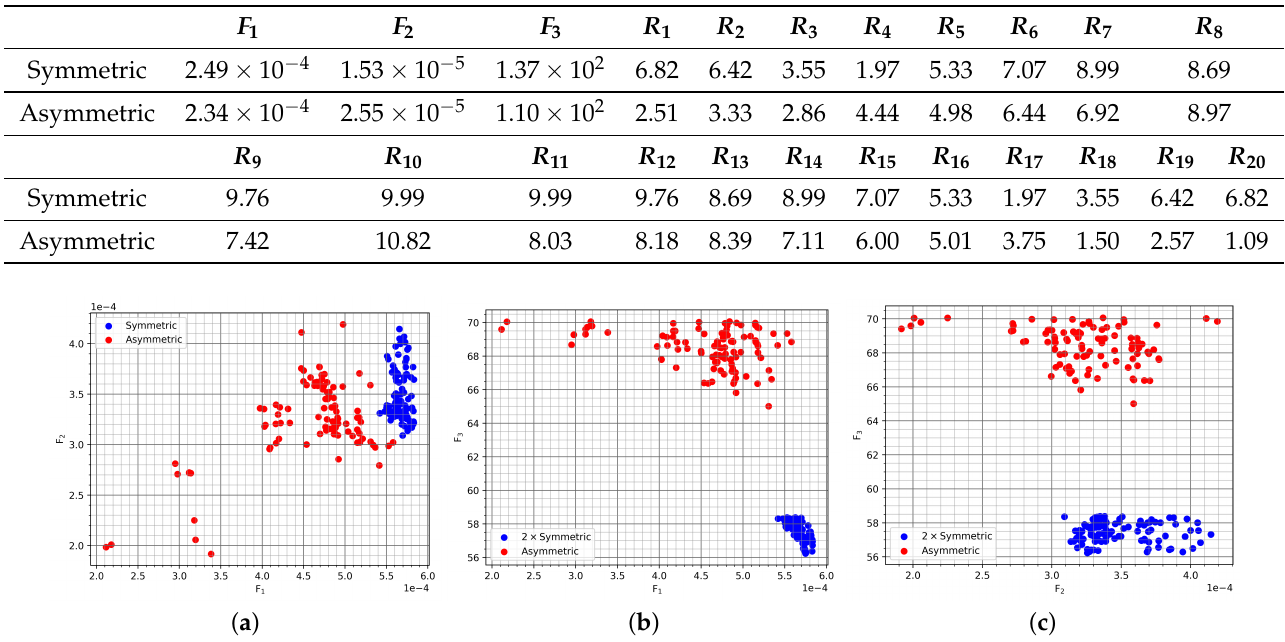
Table 5. Solutions based on the F 2 sorting in case (a).